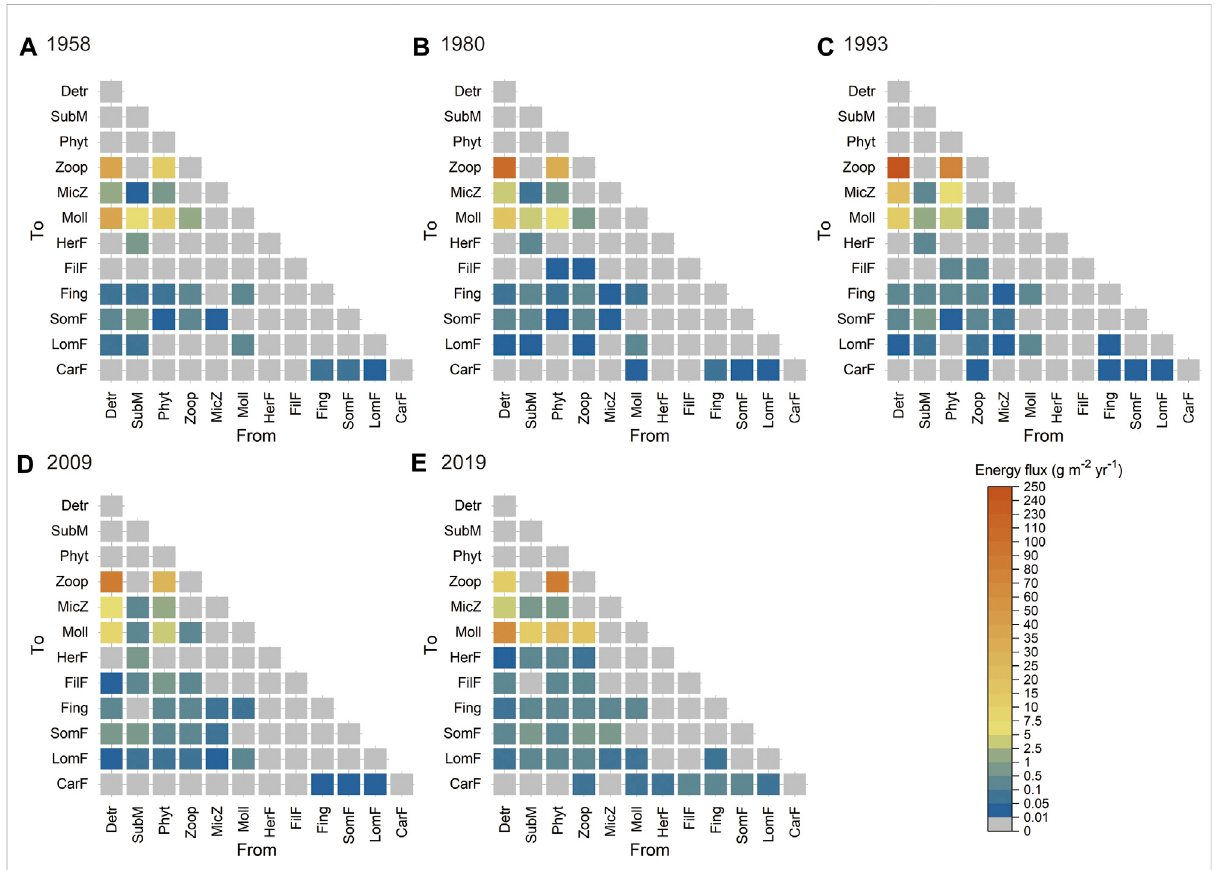
FIGURE 4 Distribution of energy fl uxes from food sources to their consumers in the food webs for fi ve representative years: (A) 1958, (B) 1980, (C) 1993, (D) 2009, and (E) 2019, represented as heat maps. Colour intensity represents the energy fl ux from the trophic groups in the column to the trophic groups in the row. Abbreviations of trophic groups: CarF, carnivorous fi sh; Detr, detritus; FilF, fi lter-feeding fi sh; Fing, fi ngerlings; HerF, herbivorous fi sh; LomF, large omnivorous fi sh; MicZ, meiofauna; Moll, mollusks; Phyt, phytoplankton; SomF, small omnivorous fi sh; SubM, submerged macrophytes; Zoop,